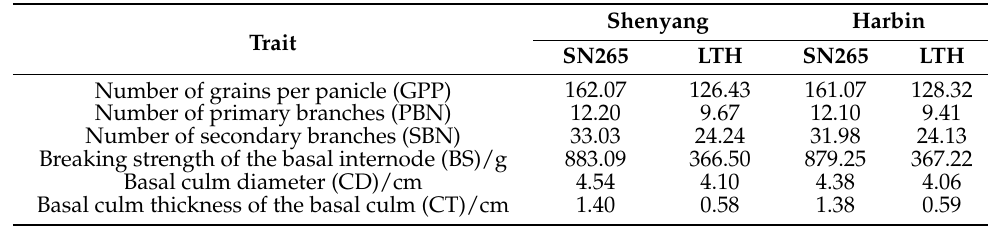
Table 1. Distribution of several panicle characters and basal culm characters of SN265 and LTH in different environments.